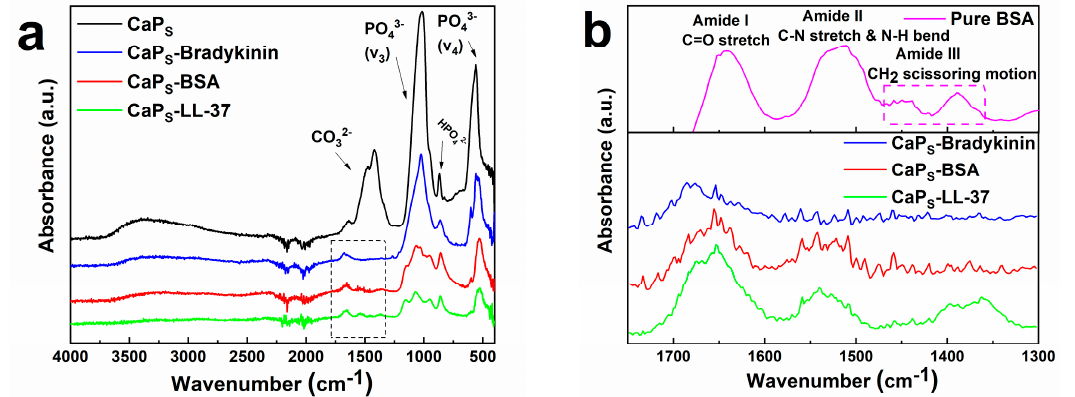
Figure 4. ( a ) Fourier-transform infrared spectroscopy (FTIR) spectra of CaP S and freeze-dried bradykinin, BSA and LL-37-loaded CaP S nanoparticles showing the characteristic absorption bands for phosphate chemical groups; ( b ) Magnified amide bond region indicating the presence of new peaks in the spectra of loaded samples, that represent amide I, amide II and amide III bonds.